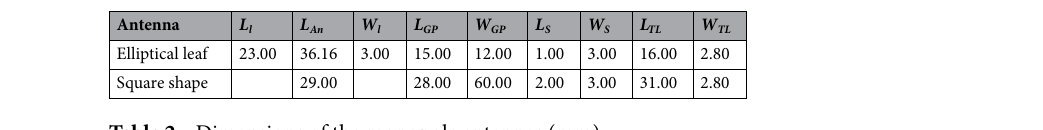
Table 2. Dimensions of the monopole antennas